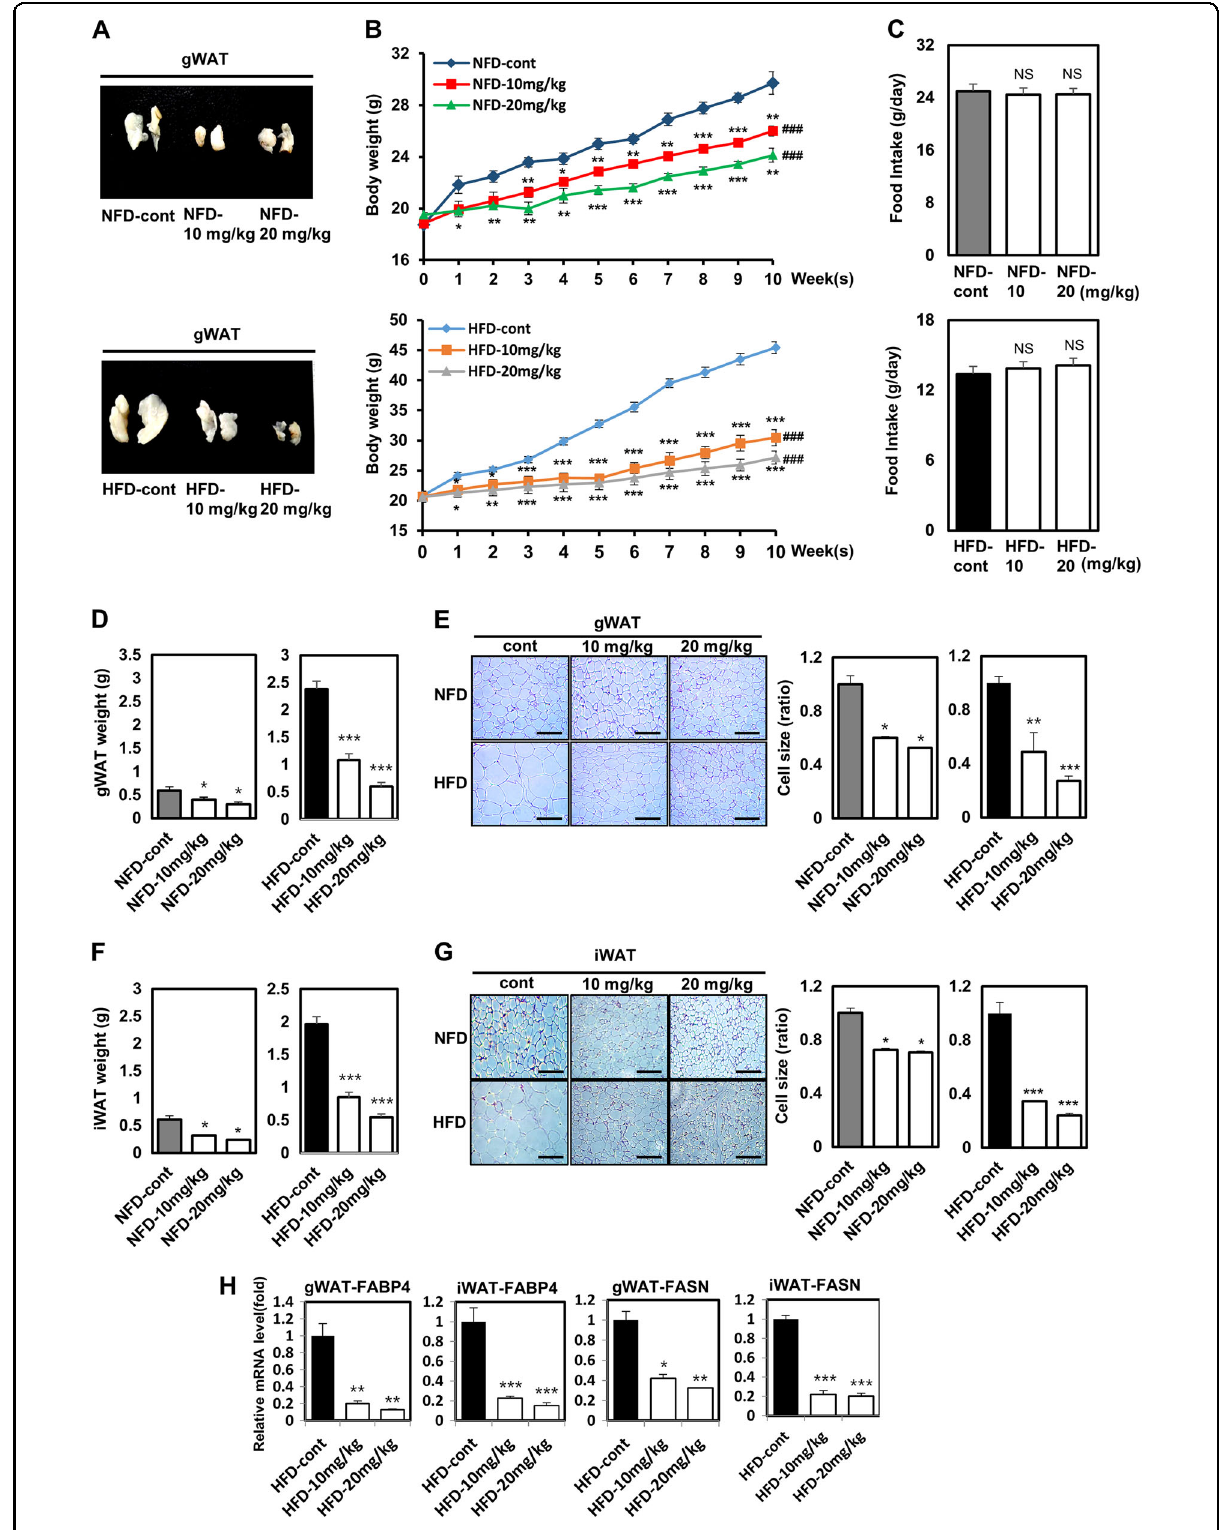
Fig. 3 (See legend on next